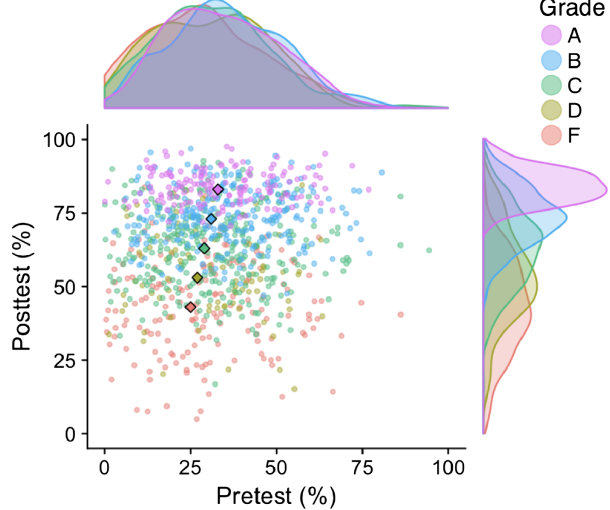
FIG. 8. Example data for an average grade distribution and high slope performance model. The diamonds are located at the means for each grade and illustrate the linear relationship between grade and mean test score. The density plots display the marginal distributions of the simulated pretest and post-test data for this simulated